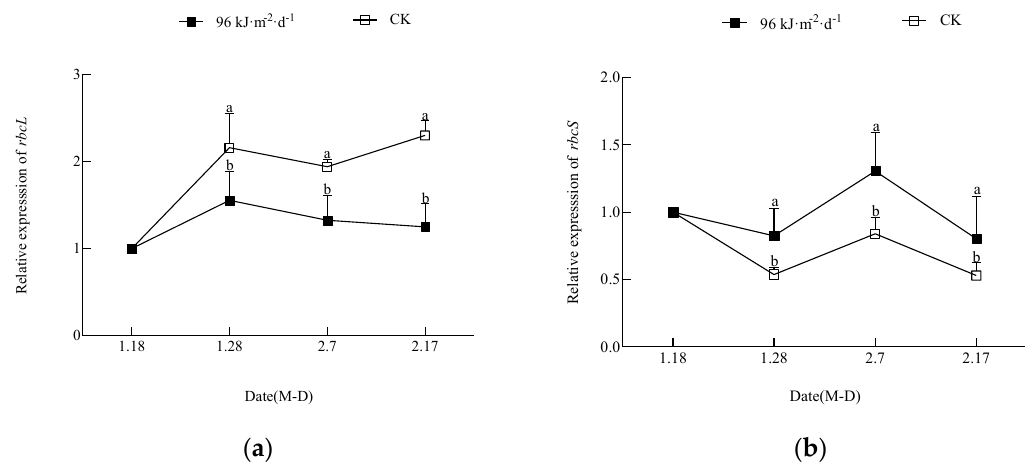
Figure 6. Effect of enhanced UV − B radiation on the gene expression of key enzymes in the photosynthesis of leaves.Note: ( a ), relative expression of rbcL ; ( b ), relative expression of rbcS.